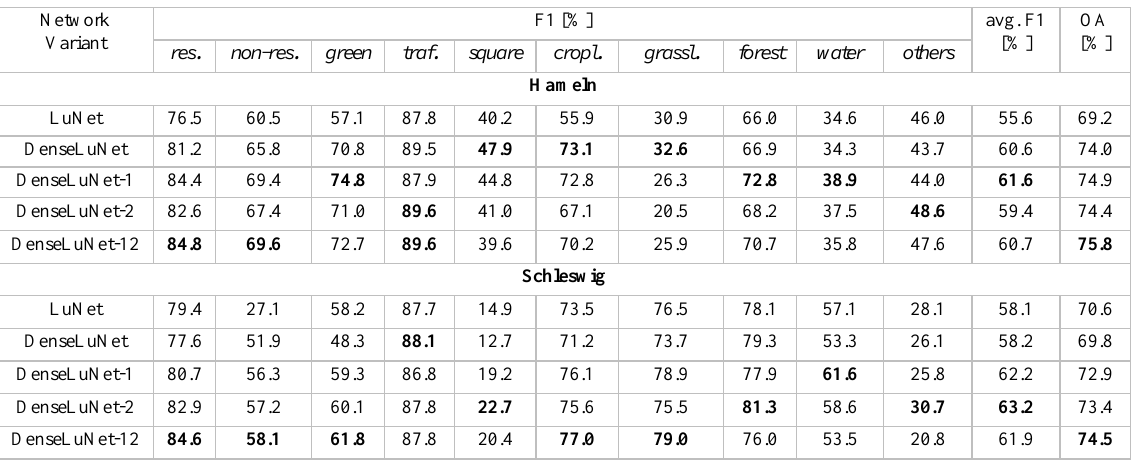
Table 1. Results of land use classification. Network variants cf. section (3.4). F1: F1 score, OA: Overall Accuracy, both evaluated on the basis of objects. Best scores are printed in